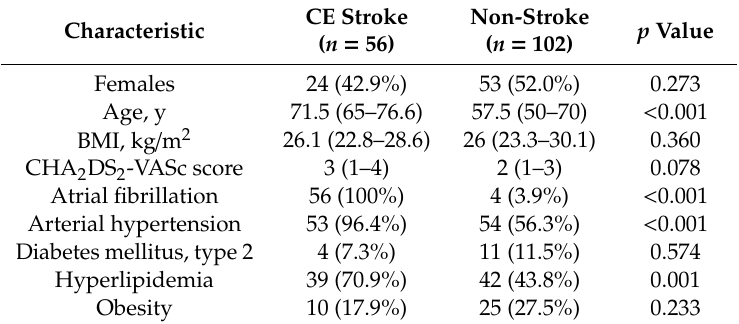
Table 1. Clinical patients’ characteristics in cardio-embolic (CE) stroke group vs.